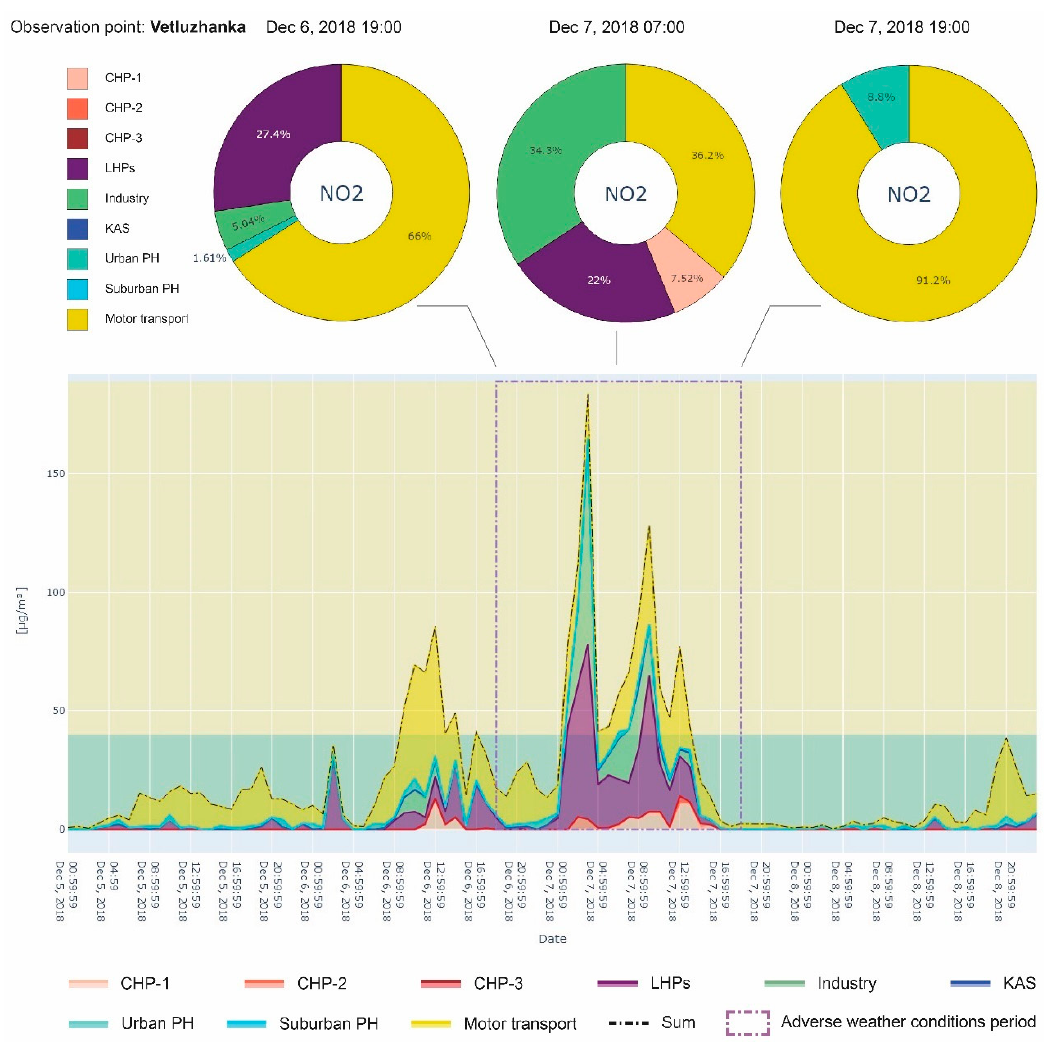
Figure 16. Simulated contributions of the main groups of emission sources in air pollution of NO 2 at 2 m height above the ground in the cells corresponding to the Vetluzhanka observation point.